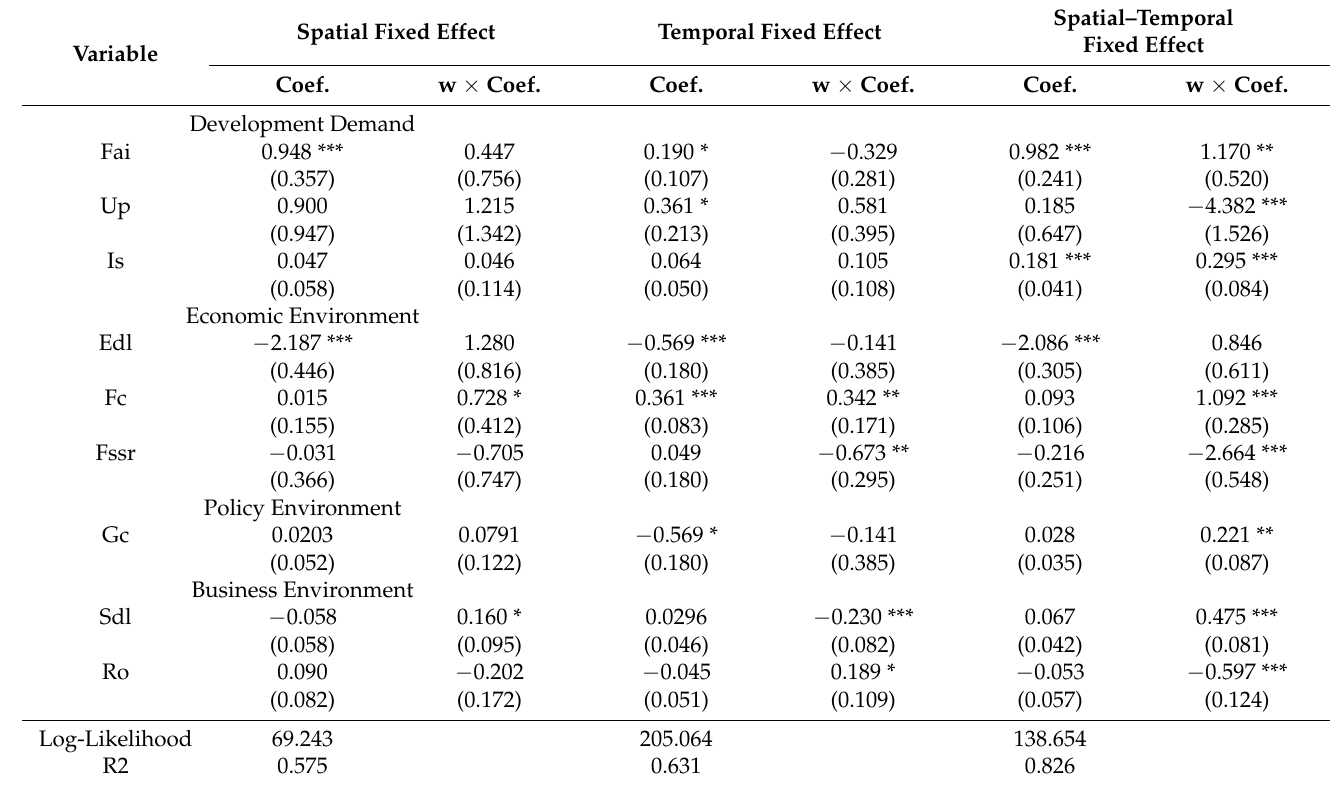
Table 4. Results of spatial panel data models with fixed effects (source: authors’